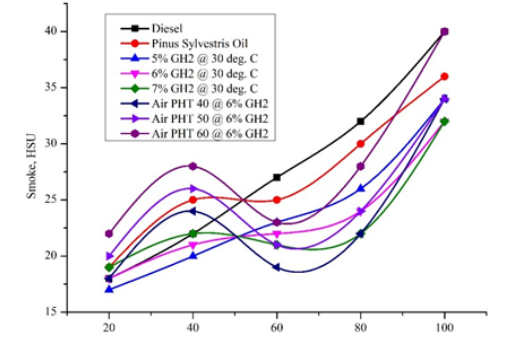
Figure 6 Smoke Vs. Engine Load